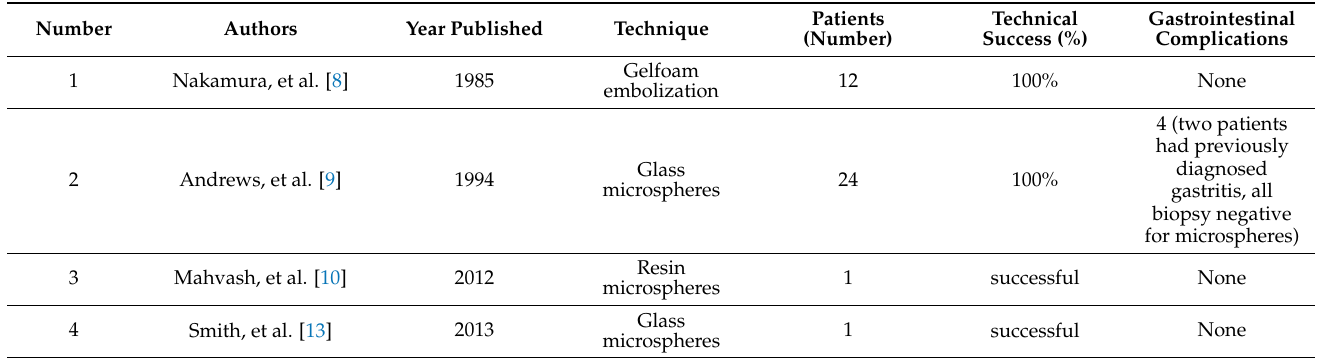
Table 4. Previous reports describing the use of balloon occlusion technique for temporary reversal of flow within hepatoenteric vessels during